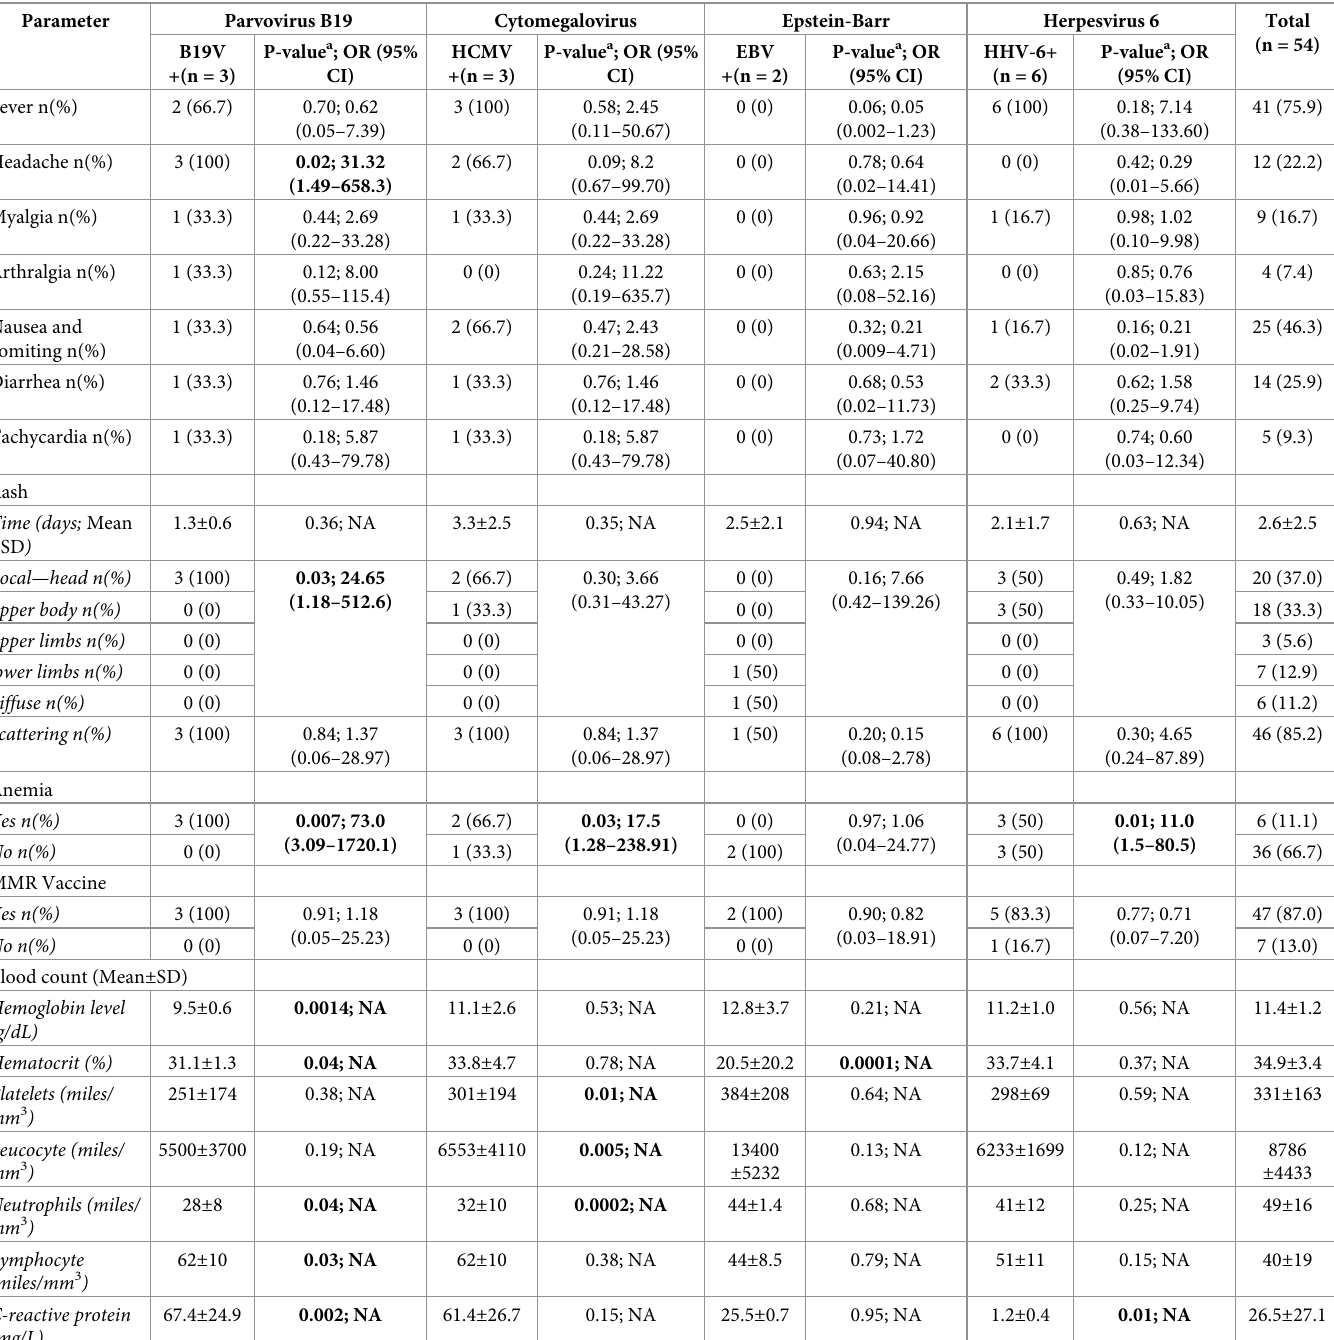
Table 5. Clinical and laboratorial findings among children and adolescents with rash diseases